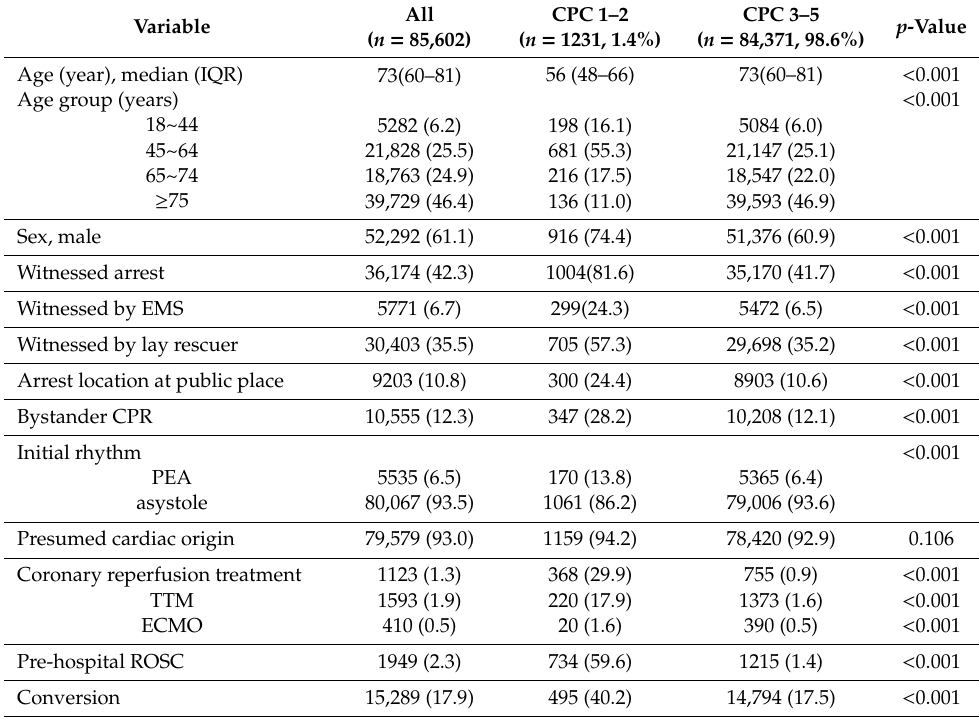
Table 1. Characteristics and resuscitation variables according to good neurologic outcome in patients with an initial non-shockable